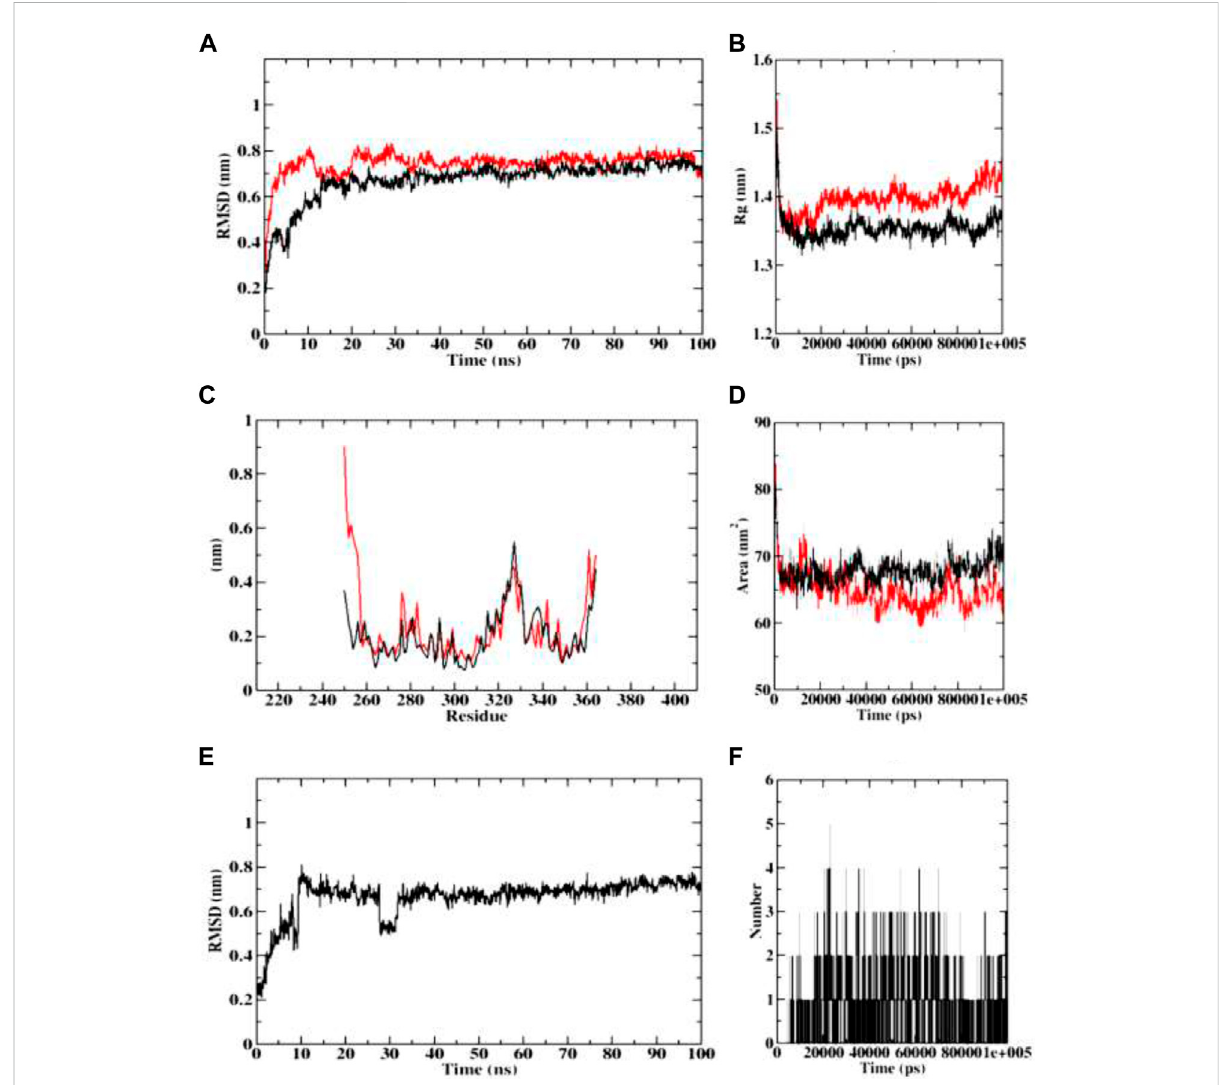
FIGURE 14 Visualization of MD trajectories of dehydronimodipine complexed with 4AQD Run for 100 ns (A) protein-ligand complex RMSD, (B) protein- ligand complex Rg, (C) protein-ligand complex RMSF, (D) protein-ligand complex SASA, (E) ligand RMSD, (F) ligand hydrogen bonds. (red: protein backbone atoms, black: protein-ligand